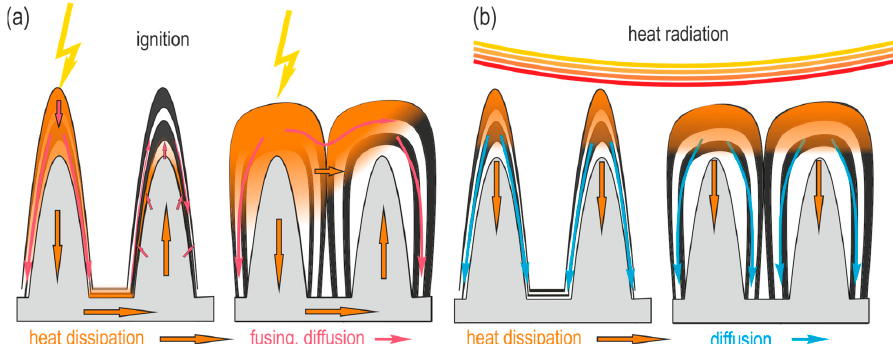
Figure 8. Schematic illustration of the mass and heat transport for thin and thick multilayers. ( a ) Spark ignition; ( b ) rapid thermal annealing.